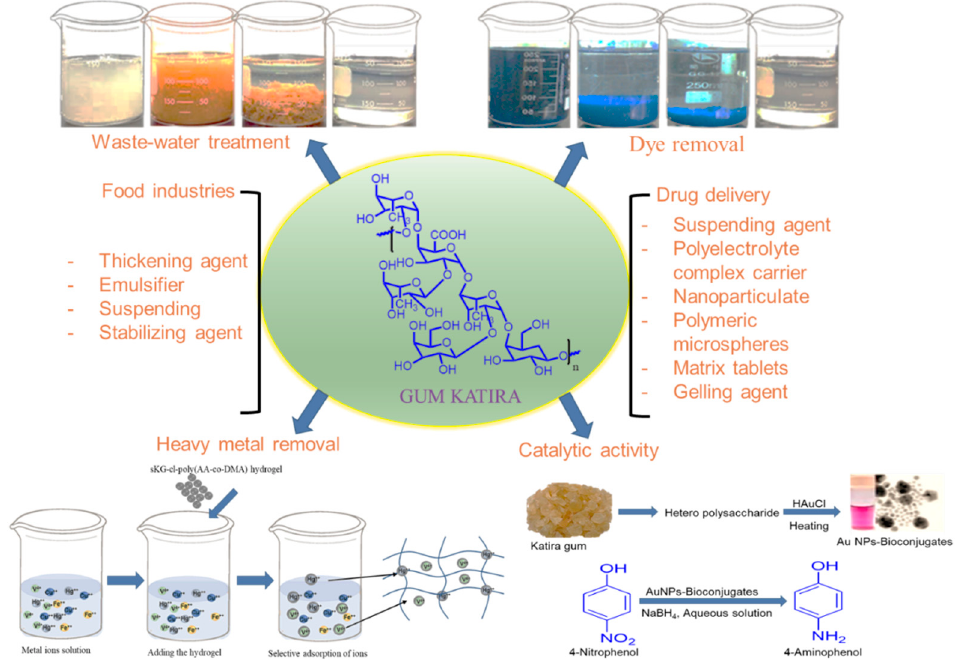
Figure 7. Applications of gum katira and modified gum katira.